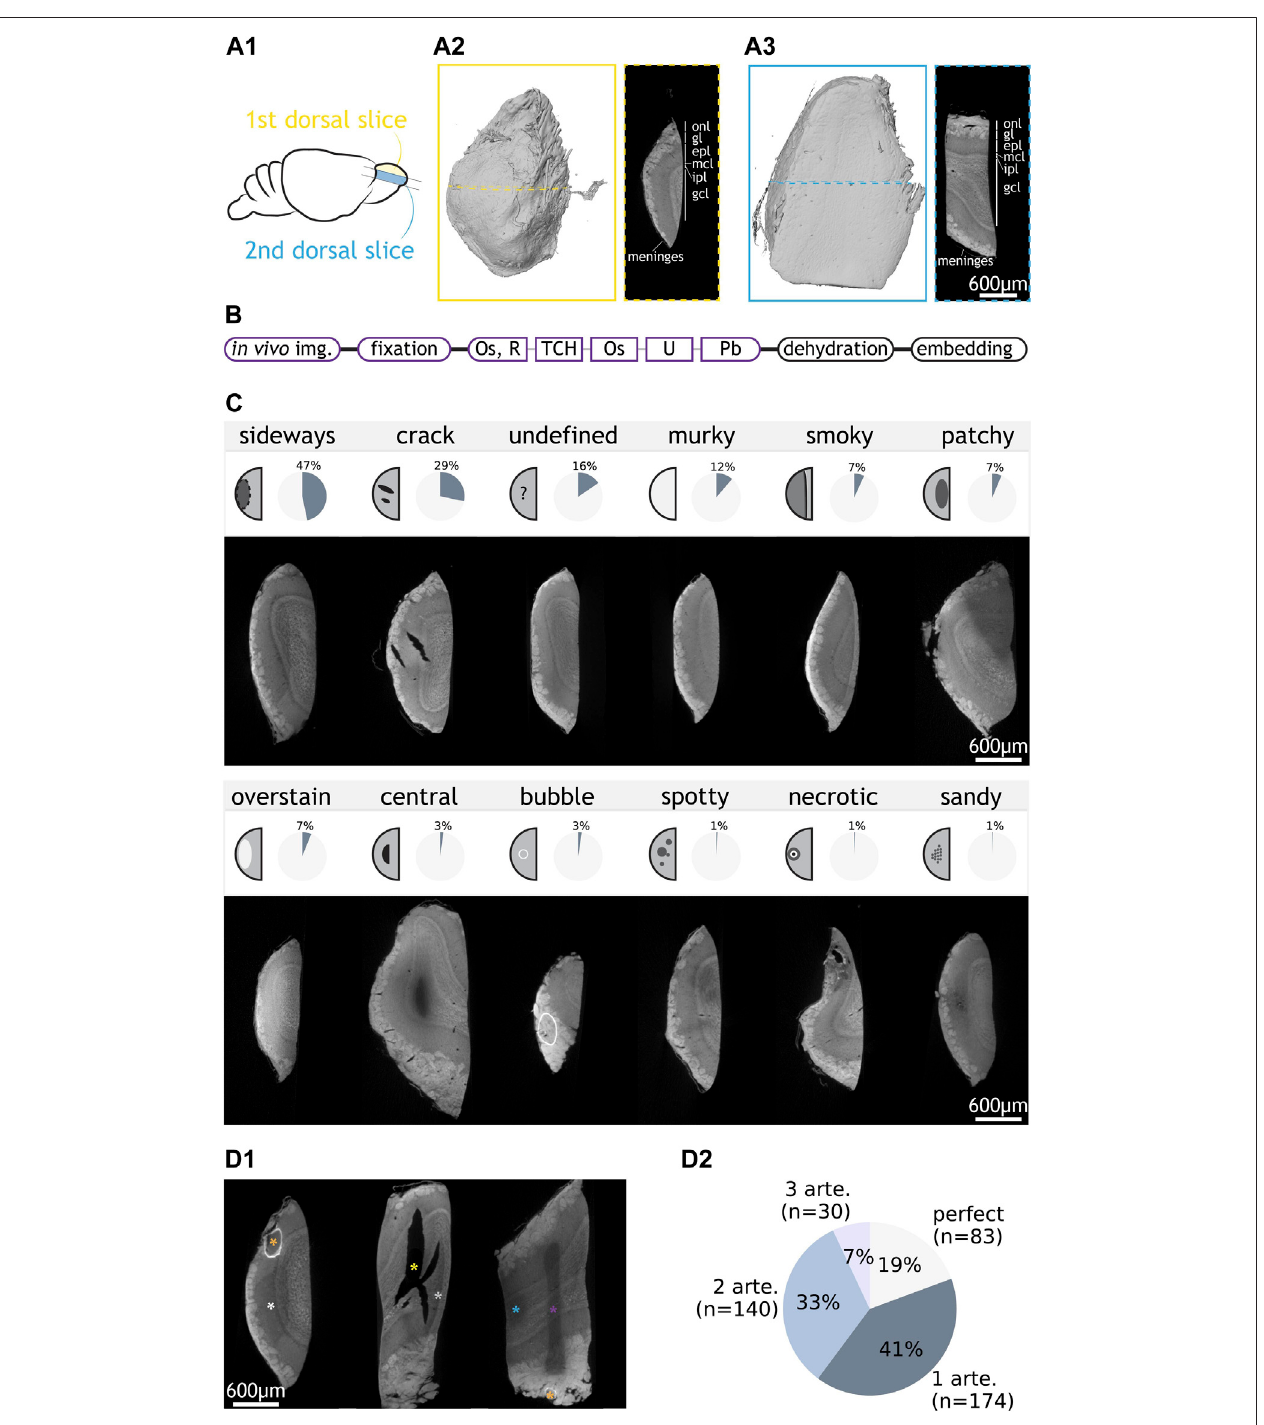
FIGURE 1 | Categorisation of staining artefacts from mouse olfactory bulb samples. (A1) Positions of the fi rst and second dorsal slices taken from the mouse olfactory bulb. (A2) LXRT volume of a fi rst dorsal slice and LXRT image of the dashed region in the volume. (A3) same as (A2) but for a second dorsal slice. (B) Structure of an SPP. Staining is split into key steps. Steps that vary between SPP tests are shown in coloured boxes. (C) 12 types of artefacts: name, schematic of appearance, overall occurrence rate in OB samples and LXRT image of a representative sample. (D1) Examples of samples with co-occurring artefacts. They respectively contain “ sideways ” (white asterisk) and “ bubble ” (orange); “ crack ” (yellow) and “ smoky ” (grey); and “ unde fi ned ” (purple), “ patchy ” (blue) and “ bubble ” (orange). (D2) NumberandpercentageofOBsampleswithzero,oneormultipleartefacts.Abbreviations:onl:olfactorynervelayer,gl:glomerularlayer,epl: external plexiform layer, mcl: mitral cell layer, ipl: internal plexiform layer, gcl: granule cell layer, img: imaging. Os: osmium tetroxide, R: reducing agent e.g., potassium ferrocyanide, TCH: thiocarbohydrazide, U: uranyl acetate, Pb: lead aspartate, arte: artefact. Scale bars are shared across all images in the same panel.